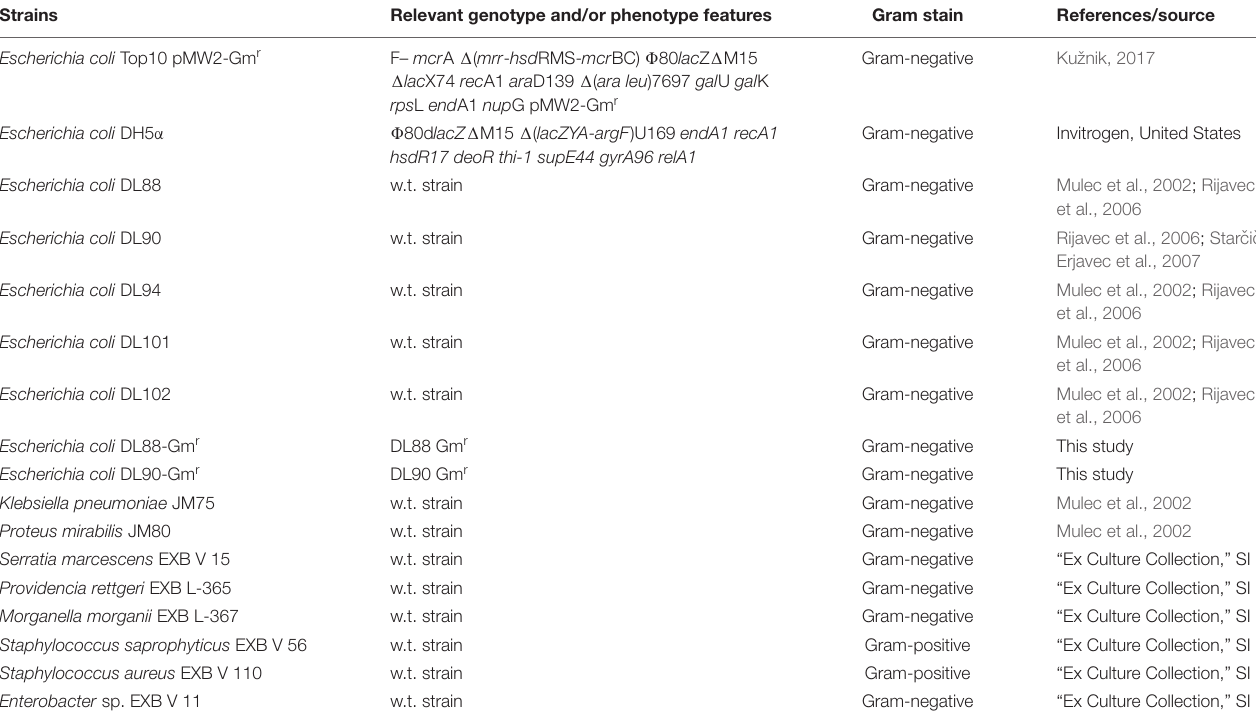
TABLE 1 | List of bacterial strains used in the experiments. Strains Relevant genotype and/or phenotype features Gram